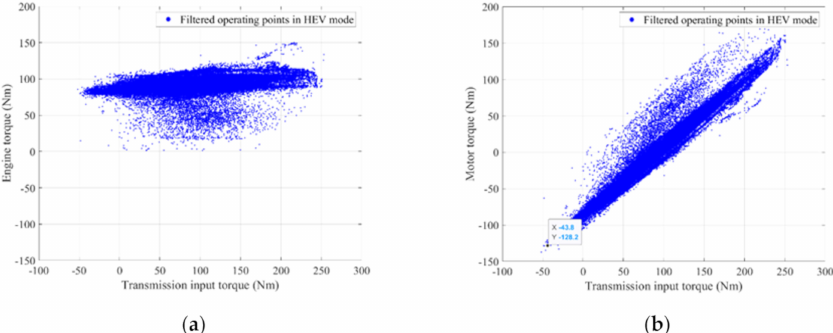
Figure 14. Engine and Motor Torque According to the Transmission Input Torque: ( a ) Engine Torque in Hybrid Mode, ( b ) Motor Torque in Hybrid Mode.